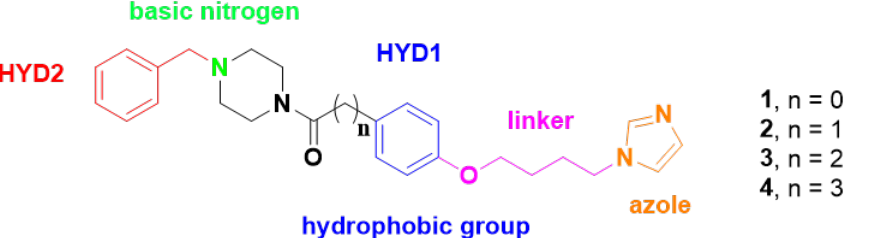
Figure 2. Structural requirements for both targets in HO-1/ σ Rs hybrids 1 – 4 are depicted in different colors. For HO-1 inhibitors: azole nucleus ( orange ), hydrophobic group ( blue ), and central linker (magenta). For σ R ligands: first hydrophobic portion HYD1 ( blue ), second hydrophobic portion HYD2 ( red ), and basic nitrogen ( green ).